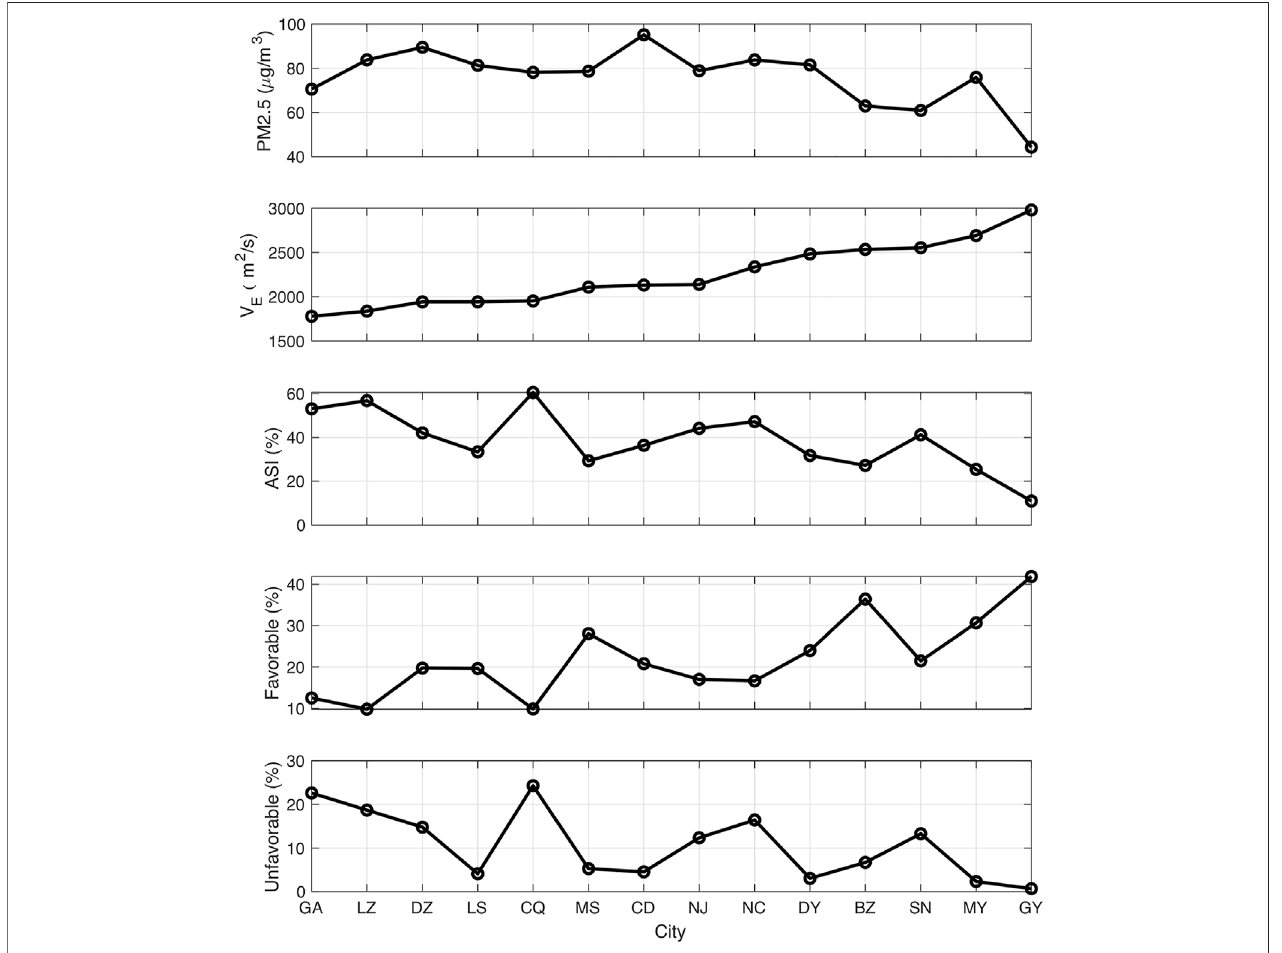
FIGURE9| VariationofwinteraveragePM2.5concentrationswithV E ,frequencyofASI,andfavorableandunfavorableconditionsinthe14citiesinthebasin.Allthe variables are the average values during the winters from 2013 to 2019. Cities are ranked by the value of V E .